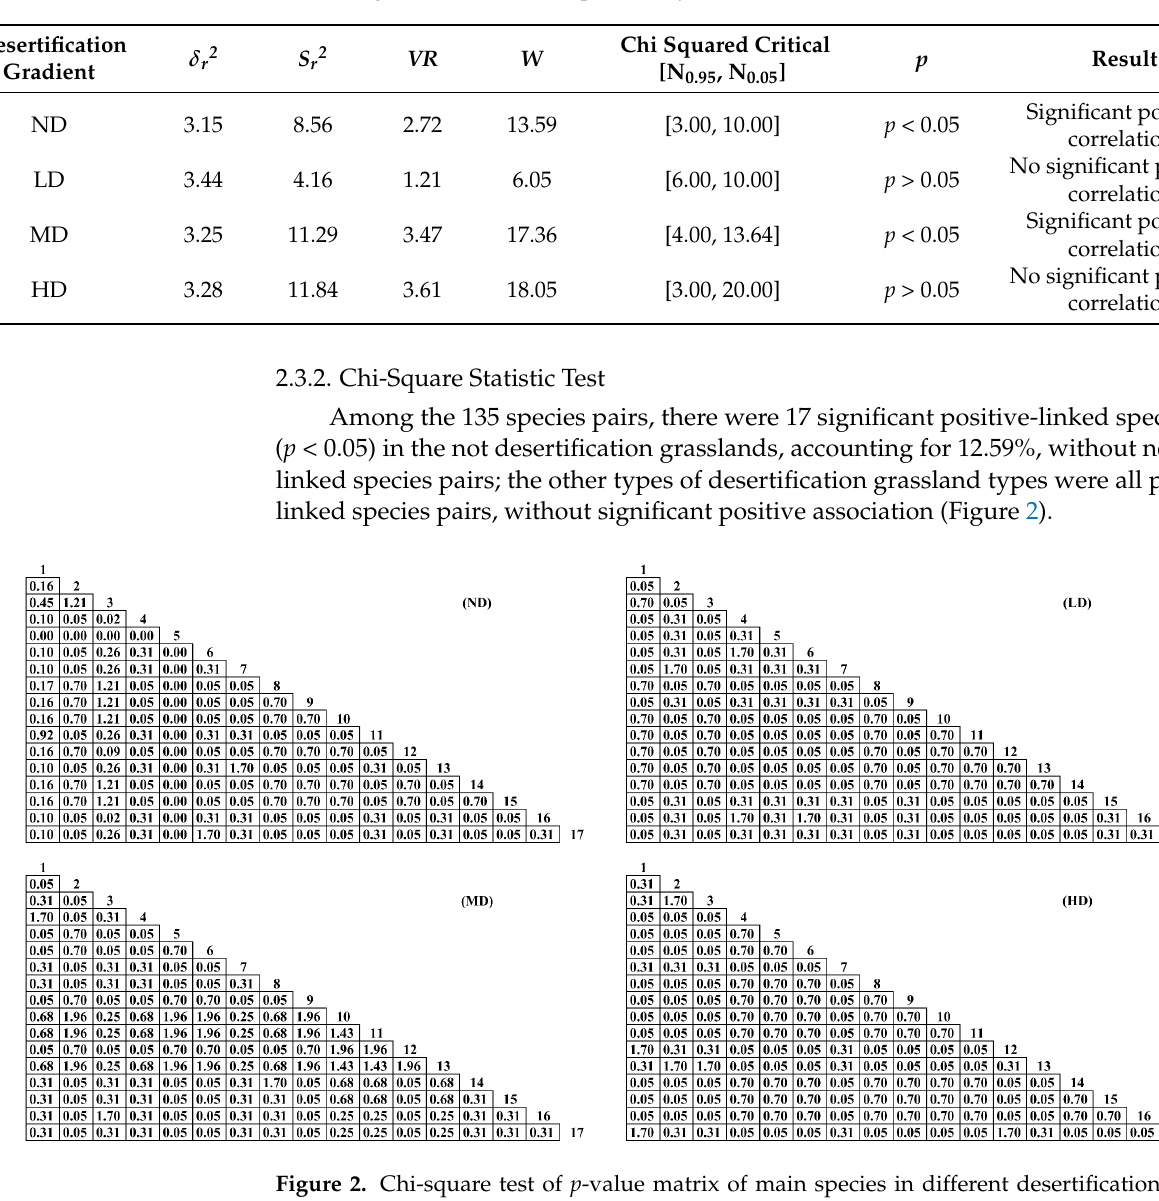
Table 2. Overall correlation of major species in different desertification stages in the Qinghai Lake Basin. The table gives the main calculation values of the overall connectedness calculation process and the significance test of the probability.